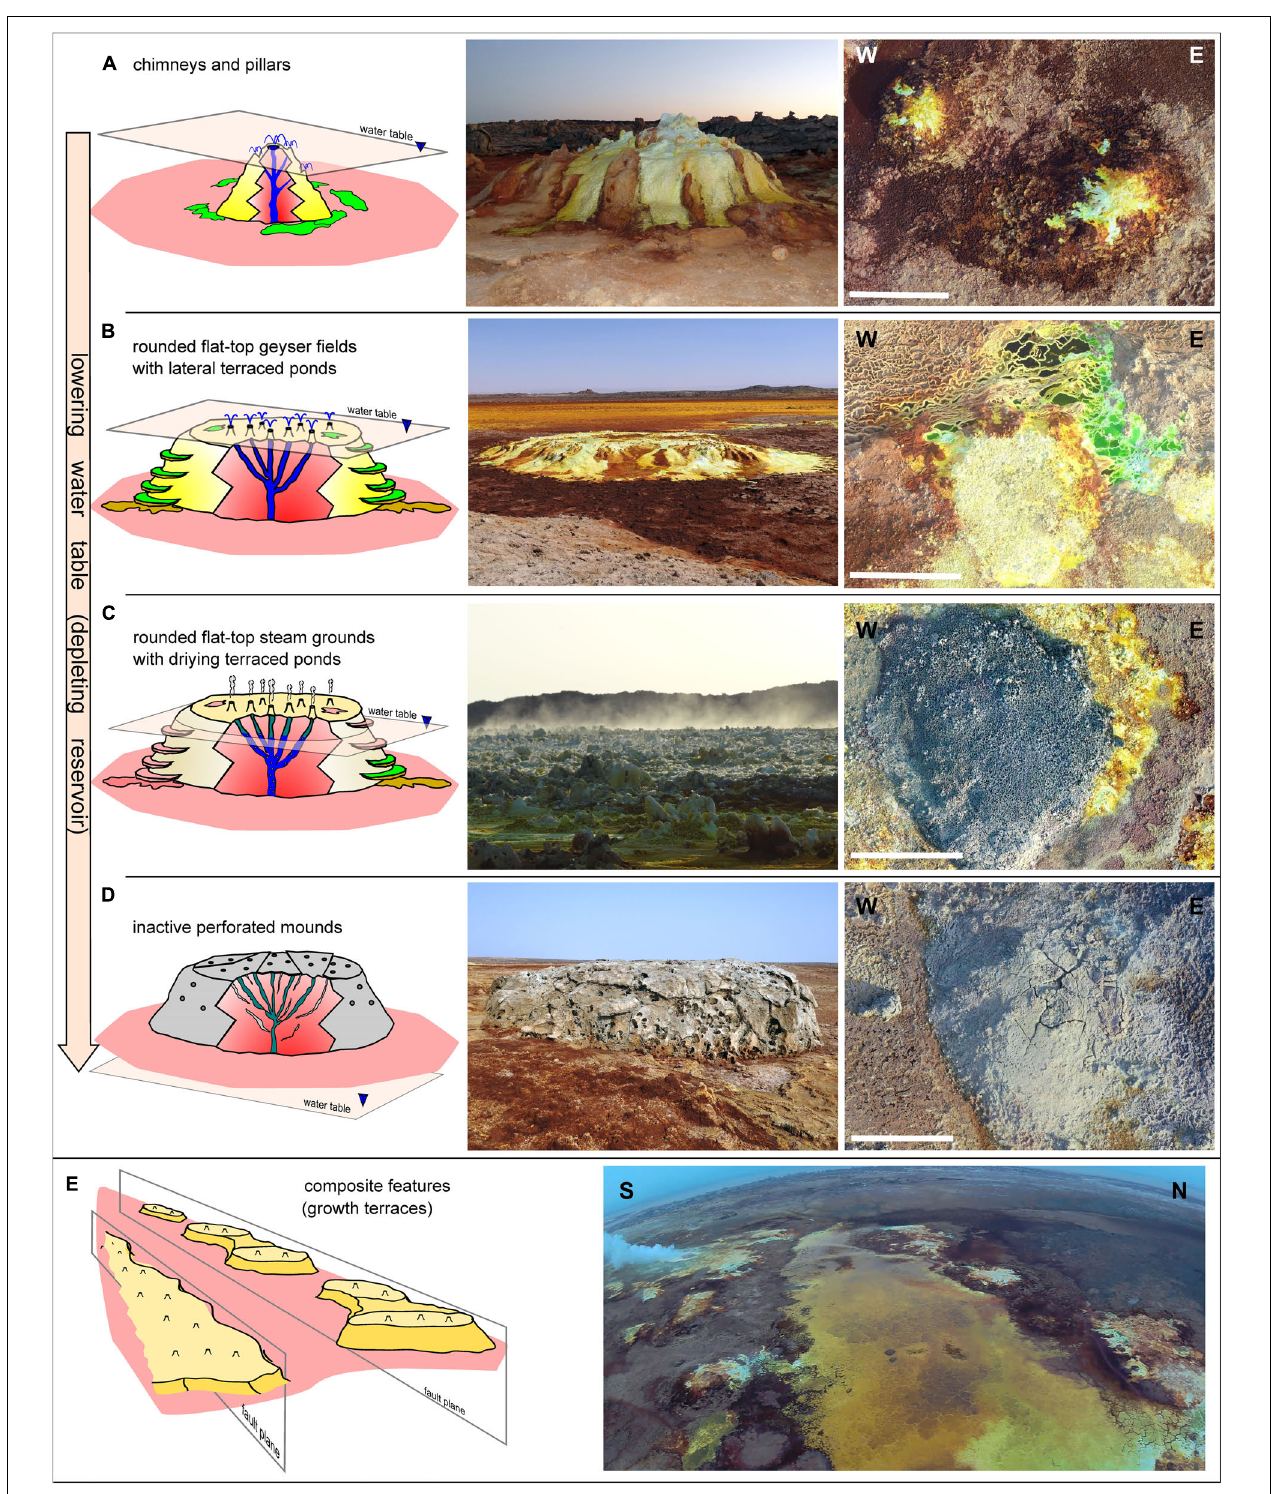
FIGURE 12 | Geomorphological evolution of rounded geothermal features and their relation with the water table level. (A) isolated pillars and chimneys. (B) Rounded flat-top geyser fields (growth-terraces) and lateral terraced ponds. (C) Rounded flat-top steam grounds and associated drying terraced ponds. (D) Inactive salt-mounds. (E) Merging of geothermal structures to form composite features. Central column: examples of ground photographs of the geothermal features described on the left column. Right column: drone high resolution images of some of the features described on the left (white bar 20 m long).